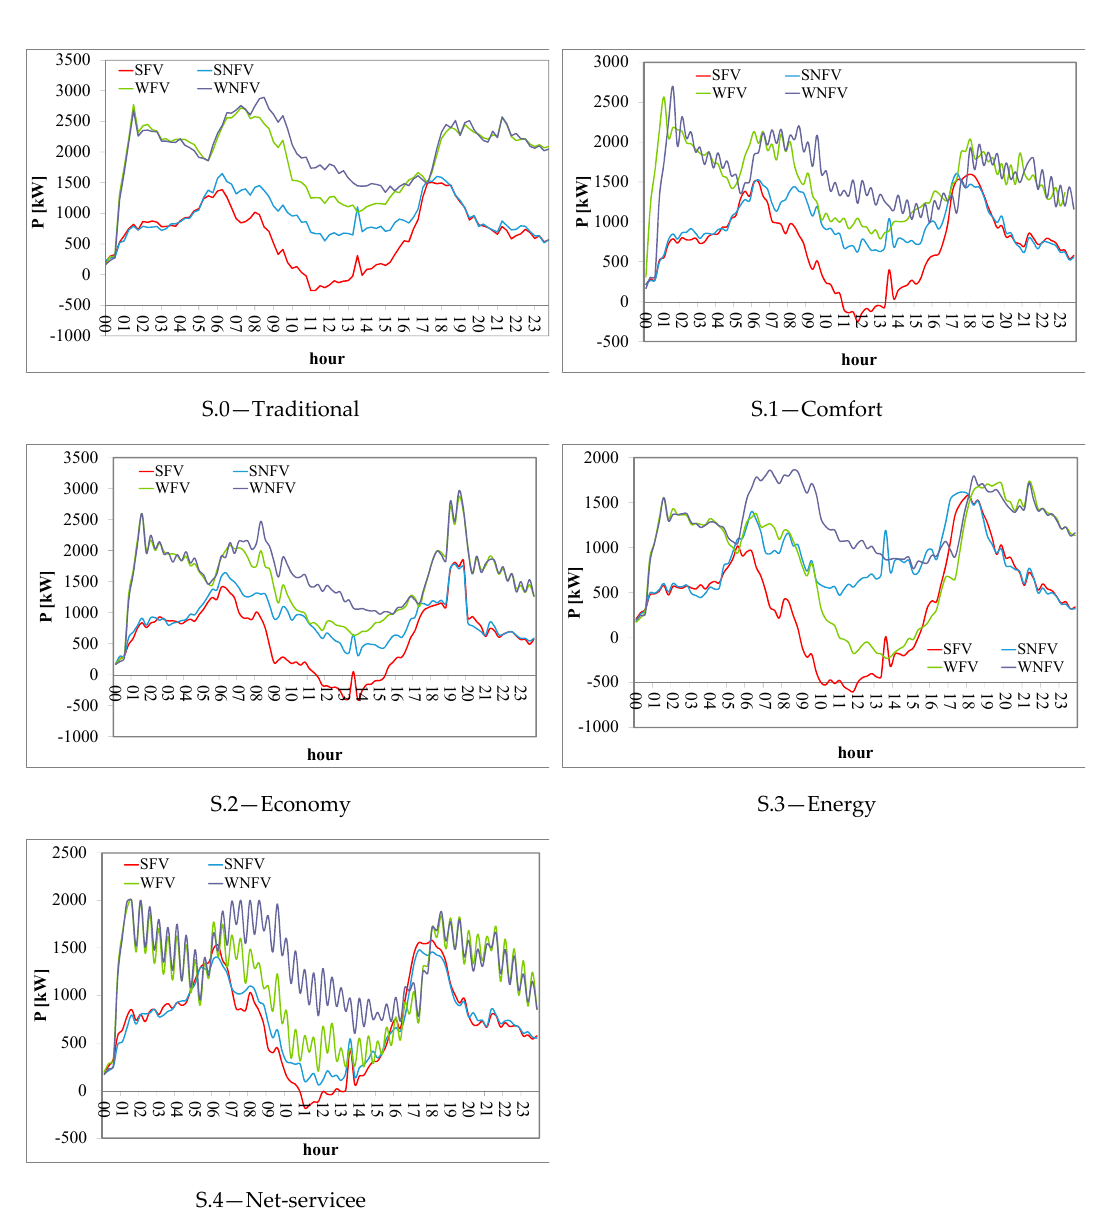
Figure 3. Turin: daily power profile at a primary substation for Scenarios S.0 to S.4. Table 4. Turin—Energy consumptions and losses for the different control logics (No